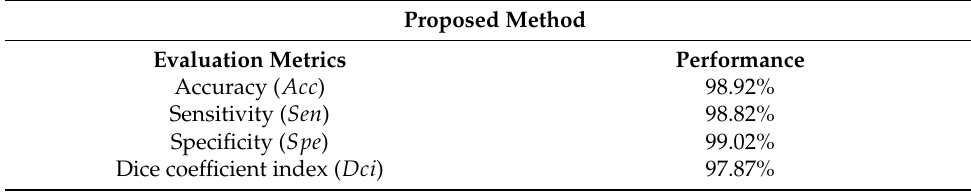
Table 5. Quantitative assessment of the proposed method using M-SVM classification.